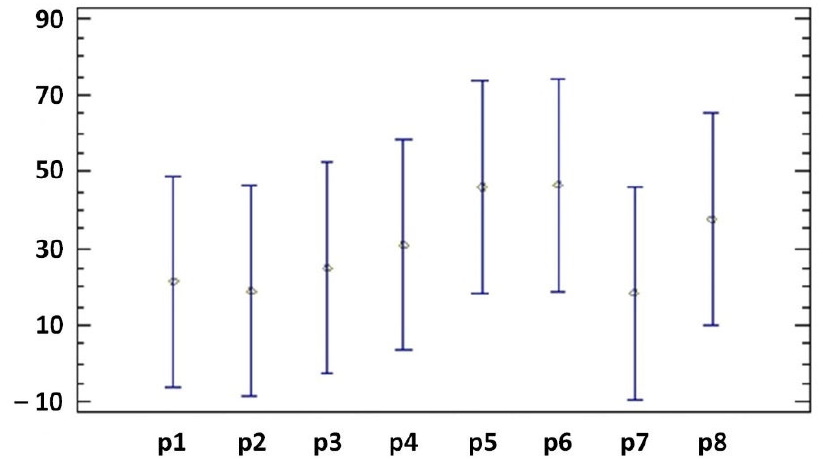
Figure 8. Means and 95% Bonferroni intervals of 2 series of experiments.